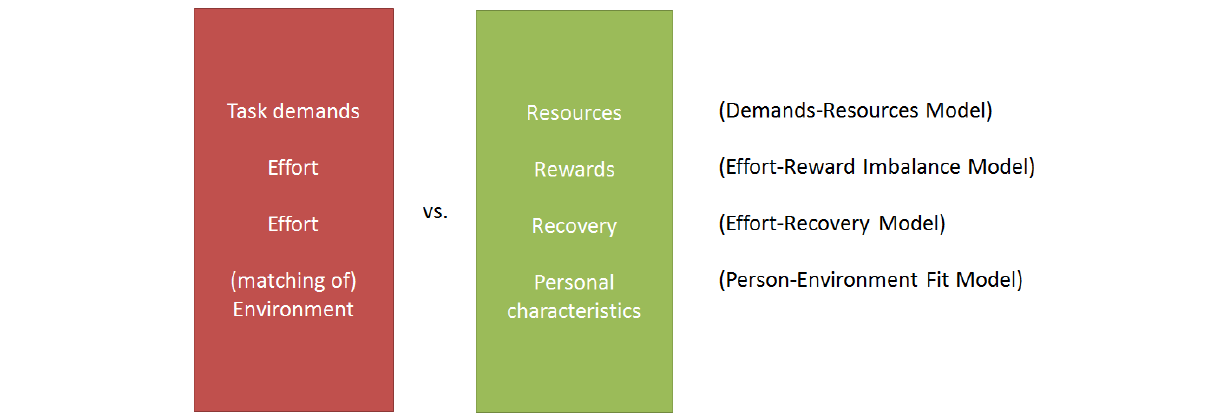
Figure 5. Different work stress